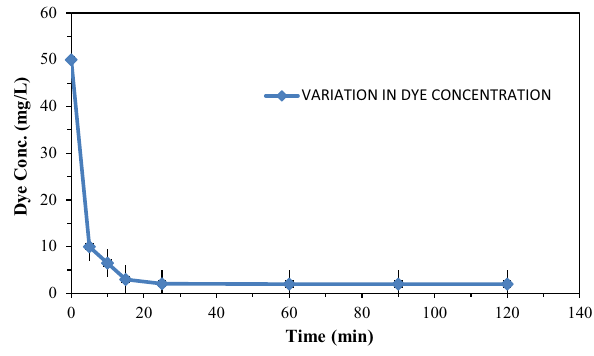
Fig. 1 Time decay curve for the adsorption of MR onto